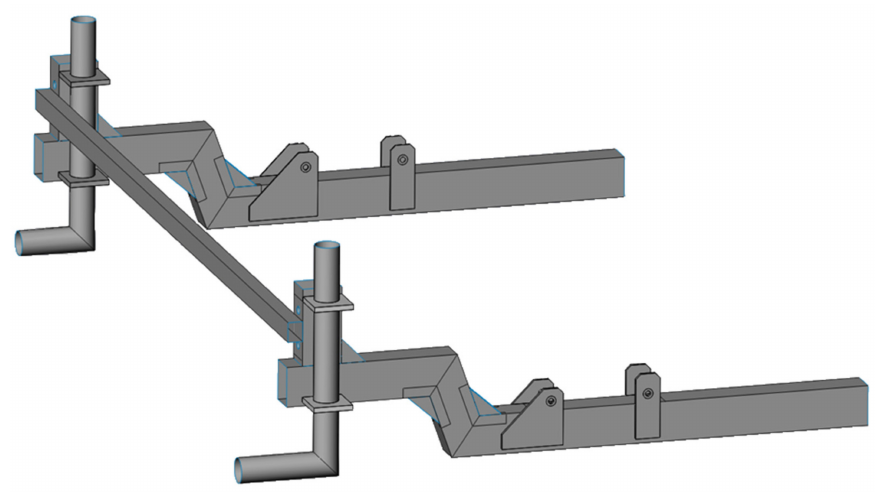
Figure 10. Implementation of crossbar